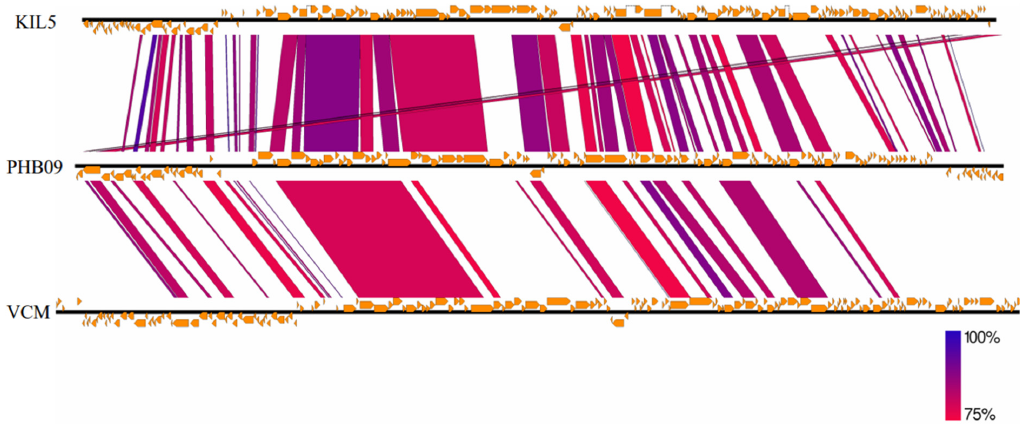
Figure 7. The genome sequence similarity between phage VCM, vB_PsyM_KIL5, and PHB09. The figure was generated via Easyfig v.2.0. Predicted genes and the direction of transcription are indicated by frames. Conserved regions are shaded, with the color intensity indicating the nucleotide sequence identity level (from 75 to 100%).